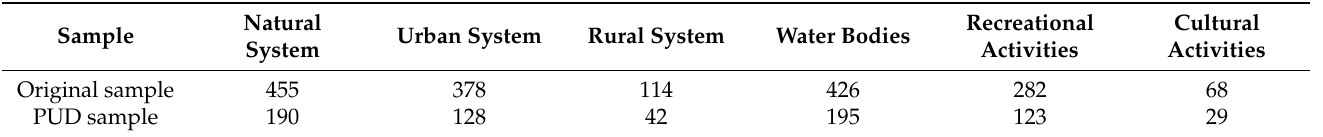
Table 3. Number of photographs in each sample and